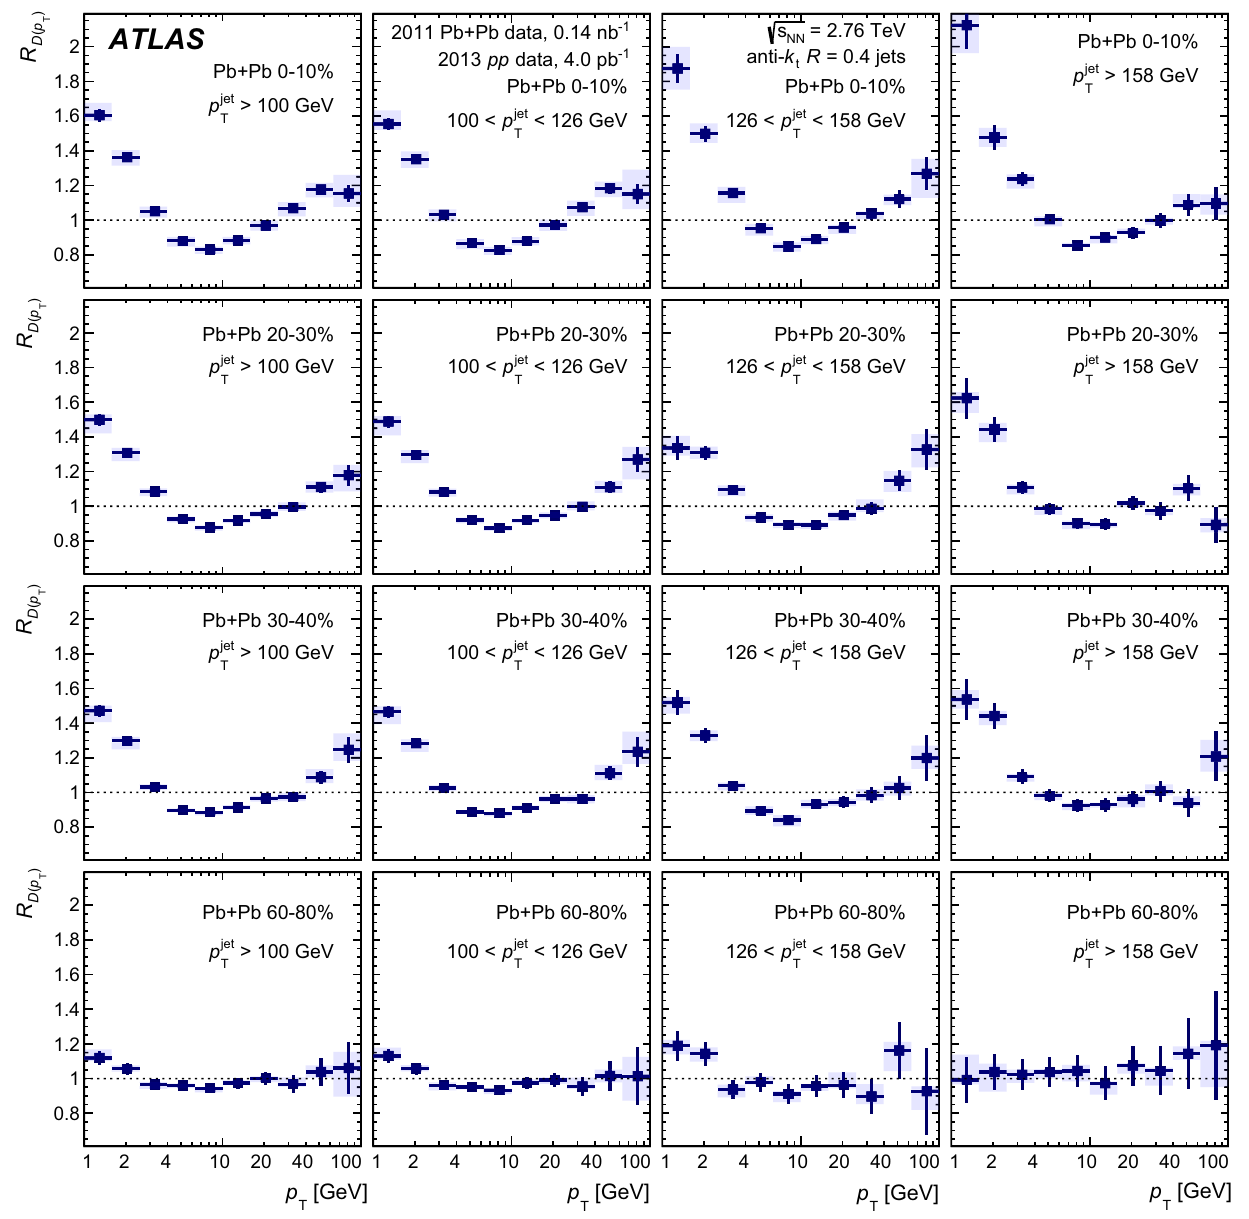
Fig. 6 The ratio R D ( p of unfolded D ( p T ) distributions measured T ) in heavy-ion collisions to unfolded D ( p T ) distributions measured in pp collisions. The R D ( p distributions were evaluated in four differ- T ) ent centrality bins ( rows ) and four different selections in jet p T of jets